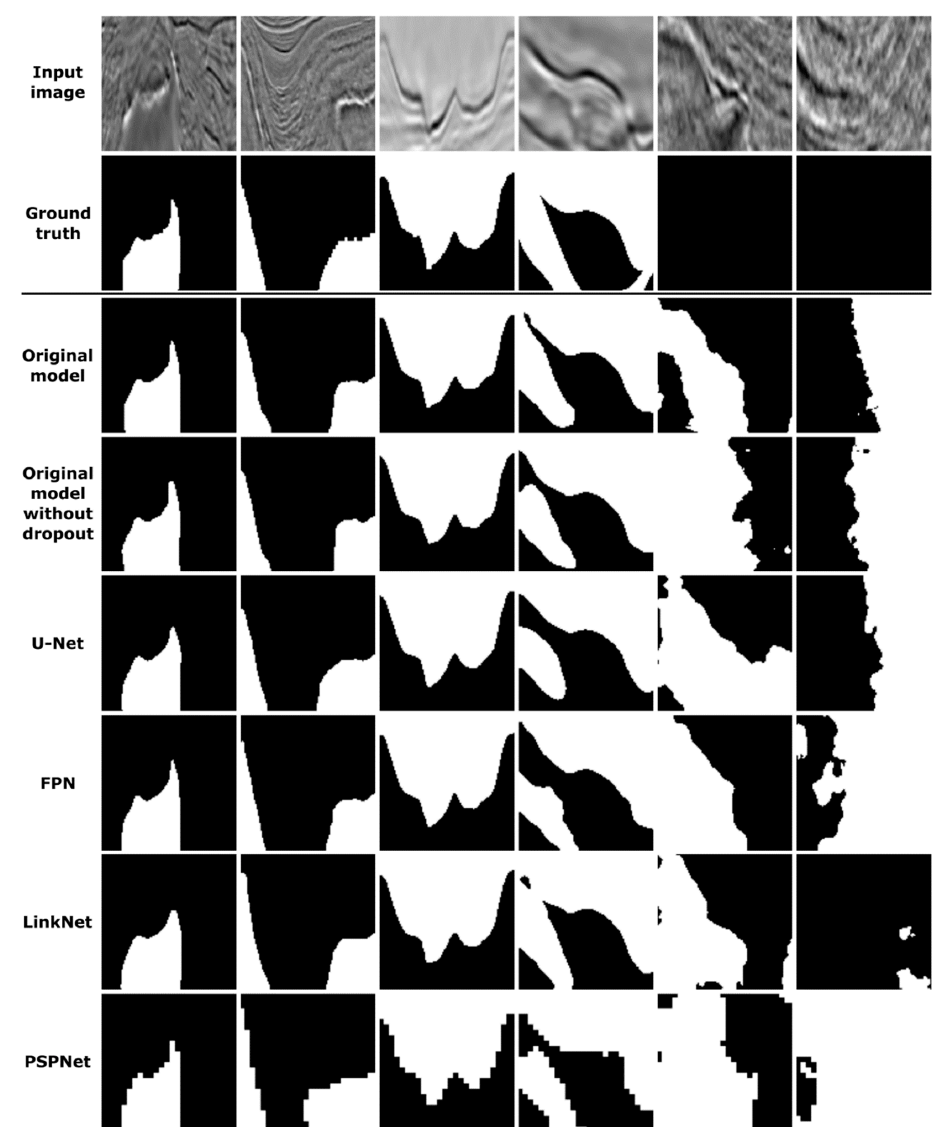
Figure 7. An example of several input seismic images with corresponding salt deposit masks (ground truth) along with predicted masks from all the models involved in the post-competition analyses. The samples are selected to illustrate both easy and hard cases.